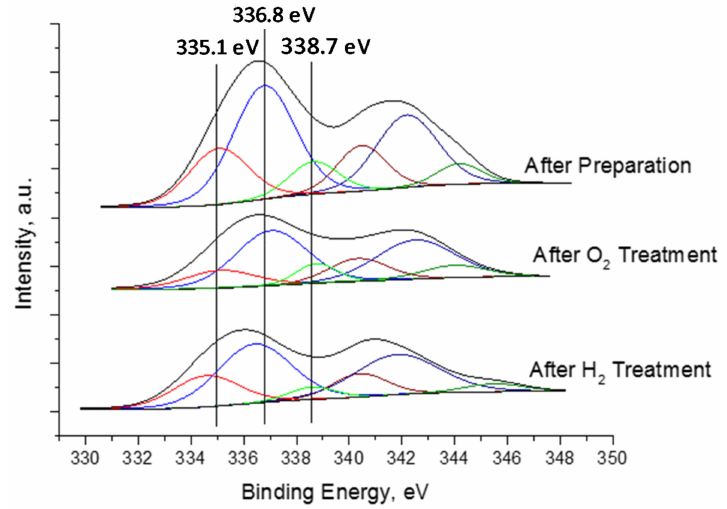
Figure 8. XPSspectraofthePd3d 5/2 core-levelaftervariousstepsofheattreatmentsofthesample1Pd1Sn/ γ - Al 2 O 3 : after preparation procedure (deposition of the metallic precursors), afteroxidative pretreatment in O 2 atmosphere at 350 ◦ C for 2 h and after reduction treatment in H 2 atmosphere at 500 ◦ C for 2